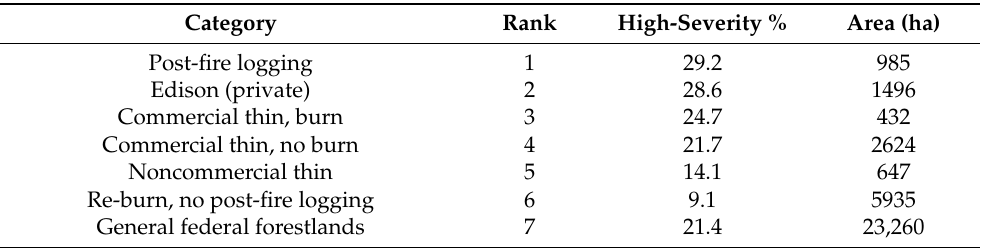
Table 2. Forest management categories and percent high-severity fire for the first four days of the Creek Fire. Category Rank High-Severity % Area (ha) Post-fire logging 1 29.2 985 Edison (private) 2 28.6 Commercial thin,